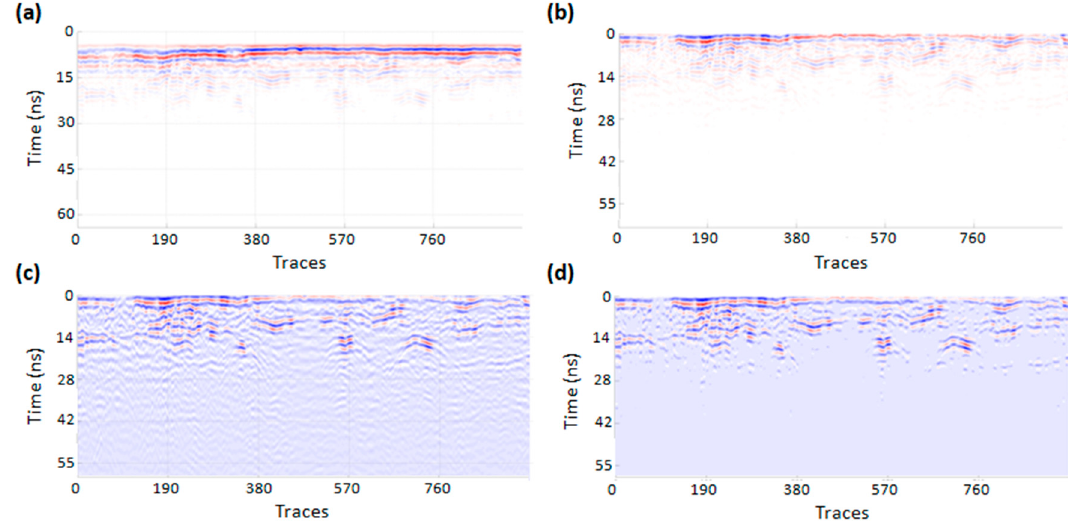
Figure 3. Data processing with the sequence raw-data ( a ), time-zero correction and 50% subtract mean trace ( b ), gain (with p = 250, q = 10, t = 0.075, s = 471) ( c ), smoothing and 25% background removal ( d ).